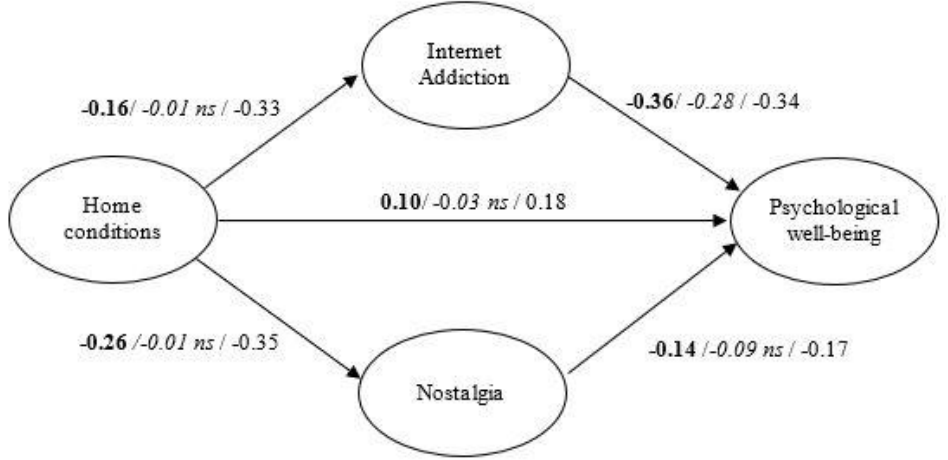
Figure 1. Research Model ( all / before 45 day /from 45 day). ns =